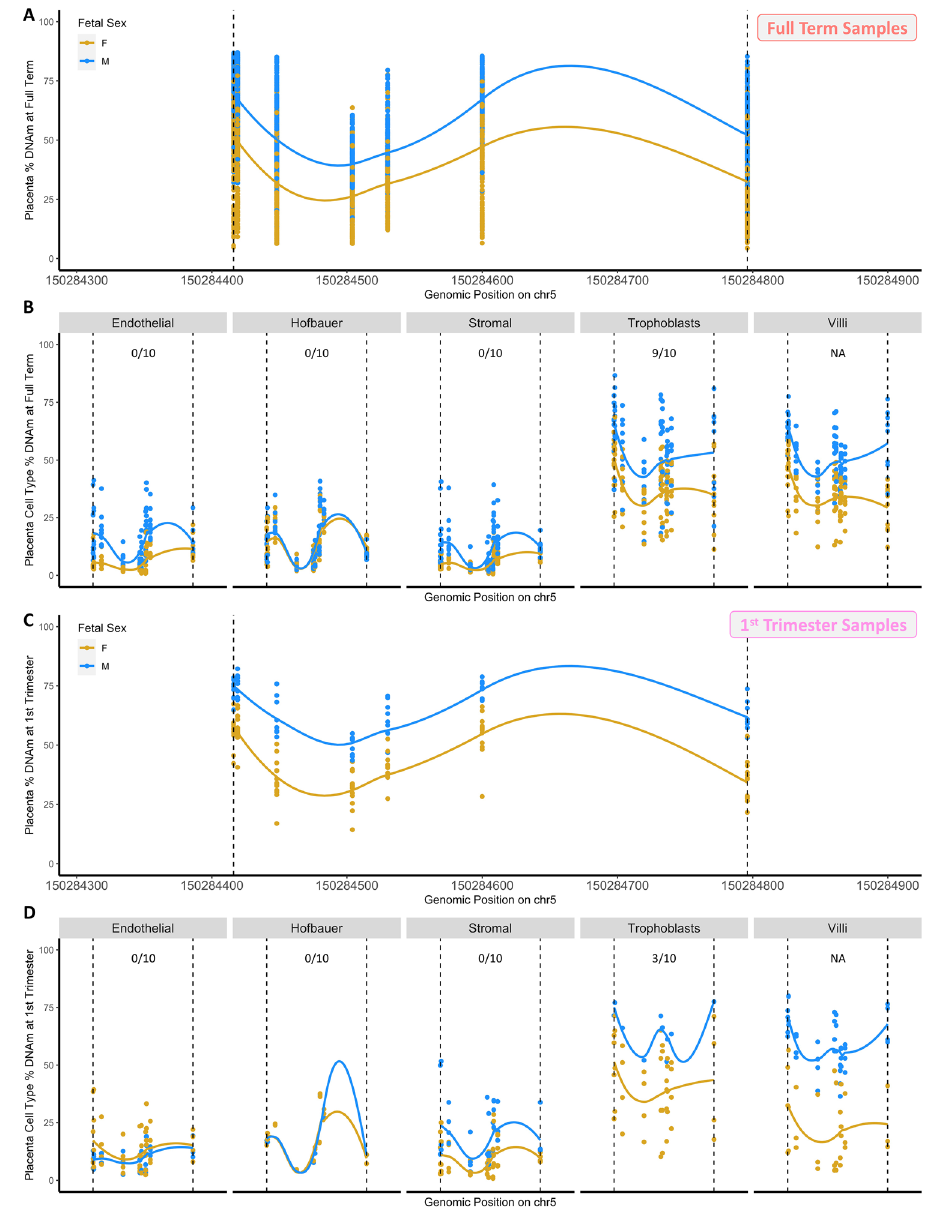
Figure 5. Cell type heterogeneity at the ZNF300 promoter. DMRs are plotted as percent methylation as a function of genomic position. Dots indicate samples and solid lines indicate smooth lines through male sample values (blue) and female sample values (gold). Actual identified DMR region indicated via dashed lines. ( A ) DMR identified at ZNF300 promoter on chromosome 5 in full term analysis, plotted using full term samples from present study. ( B – D ) The same region, but plotted using samples from different datasets. ( B ) Term samples and individual placenta cell types from Yuan et al. ( C ) 1st Trimester samples from present study. ( D ) 1st trimester samples and individual placenta cell types from Yuan et al. In b + d, fractions indicate the proportion of probes in the region that were annotated by Yuan et al. as distinguishing that cell type in full term and 1st trimester samples, respectively. Villi samples were not evaluated in this manner by Yuan et al. as this is the unsorted bulk